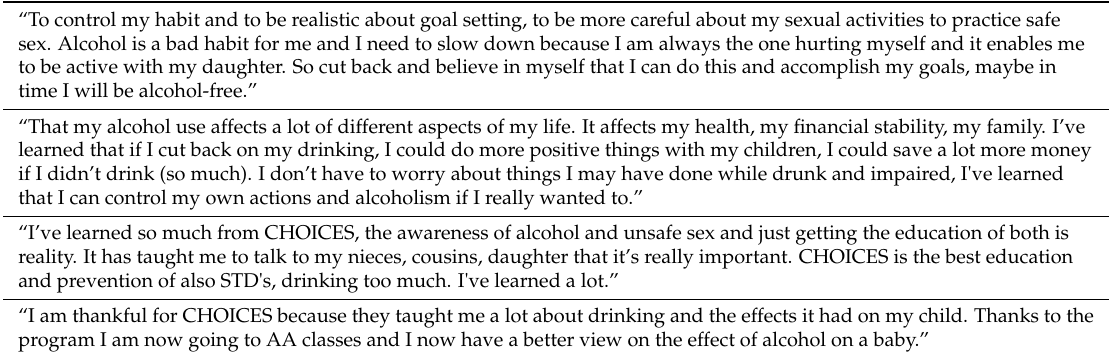
Table 3. Opinions of OST CHOICES participants on the